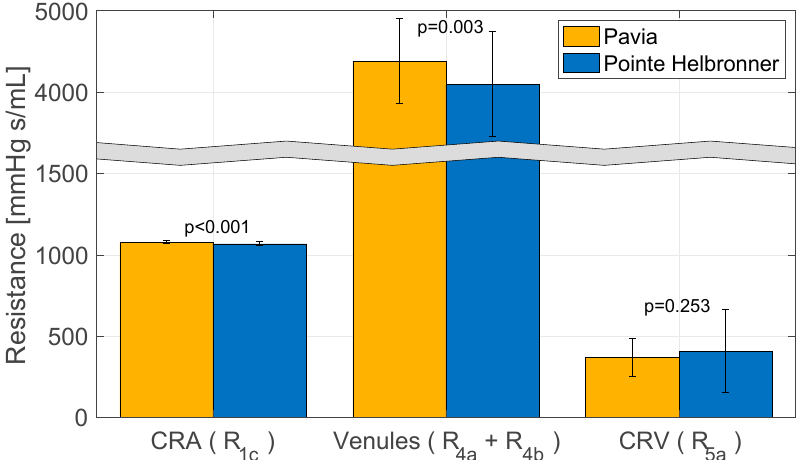
Figure 5. The physiology − enhanced retinal hemodynamics analysis predicted average values and standard deviation of resistances of the intraocular segments of the central retinal artery (CRA) (R 1c ), central retinal vein (CRV) (R 5a ), and retinal venules (R 4 = R 4a + R 4b ) for the two locations/altitudes